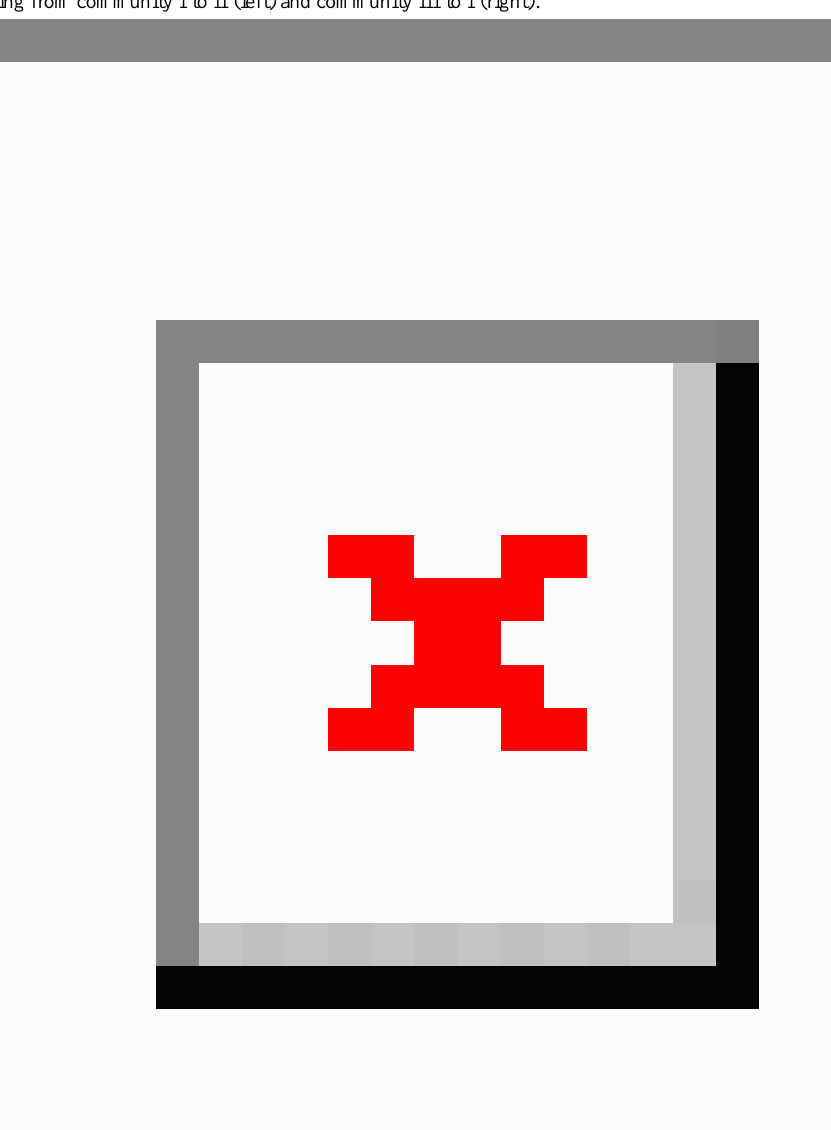
Figure 9. The probability that one community will seed an epidemic in another sufficiently late to produce an asynchronous secondary wave is shown for epidemics spreading from community I to II (left) and community III to I